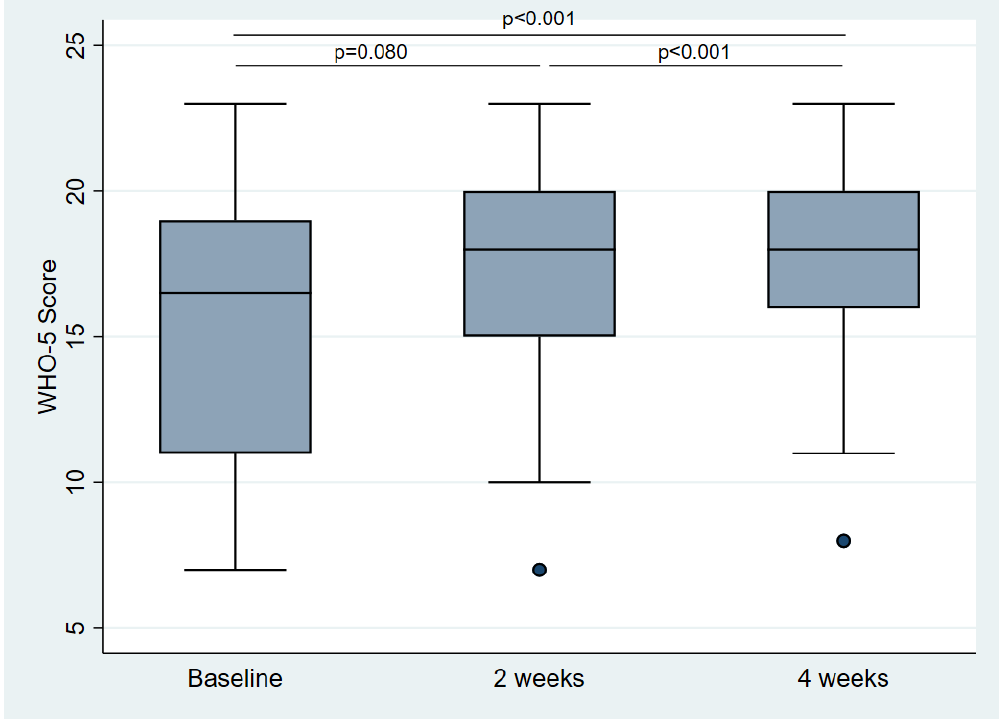
Figure 4. Changes in Quality of Life through intermittent fasting assessed by the WHO-5 question- naire.